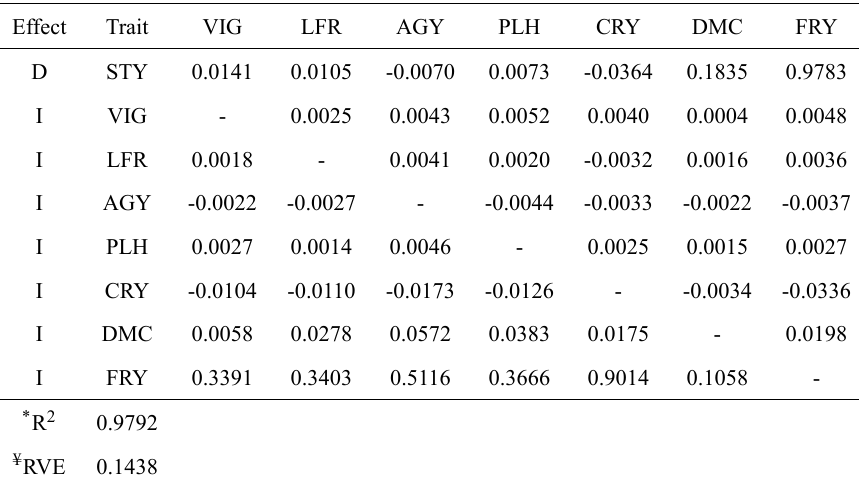
Estimates of the direct (D) and indirect (I) effects of the independent variables on starch yield (STY) through path analysis based on genetic correlations from the evaluation of 814 cassava